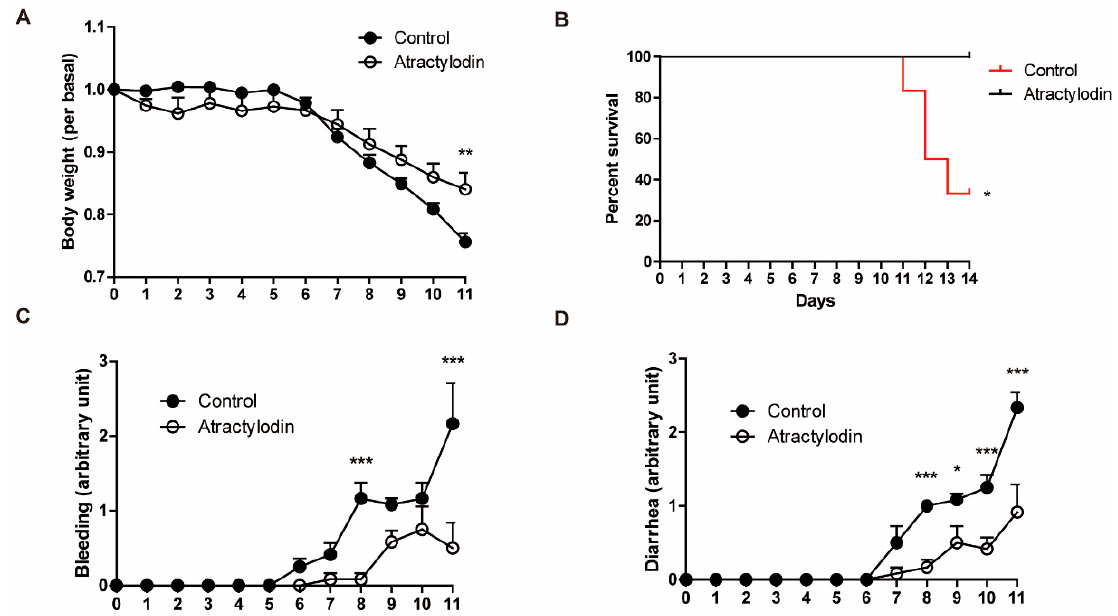
Figure 5. Anti-inflammatory effects of atractylodin in a DSS-induced colitis mouse model. Mice received 2.5% DSS in drinking water for 14 d. Vehicle or atractylodin was administered orally once a day during the DSS administration pe-riod (n = 6). ( A ) Body weight was measured daily and is presented as a relative value of day 0. ( B ) Survival rate was ana-lyzed using the log-rank test ( p = 0.0209). ( C , D ) Clinical symptoms were scored daily on a scale of 0–4. Body weight, bleeding, and diarrhea data were recorded until the first mouse was sacrificed (day 11). * p < 0.05, ** p < 0.01, and *** p < 0.001 compared to the control group.